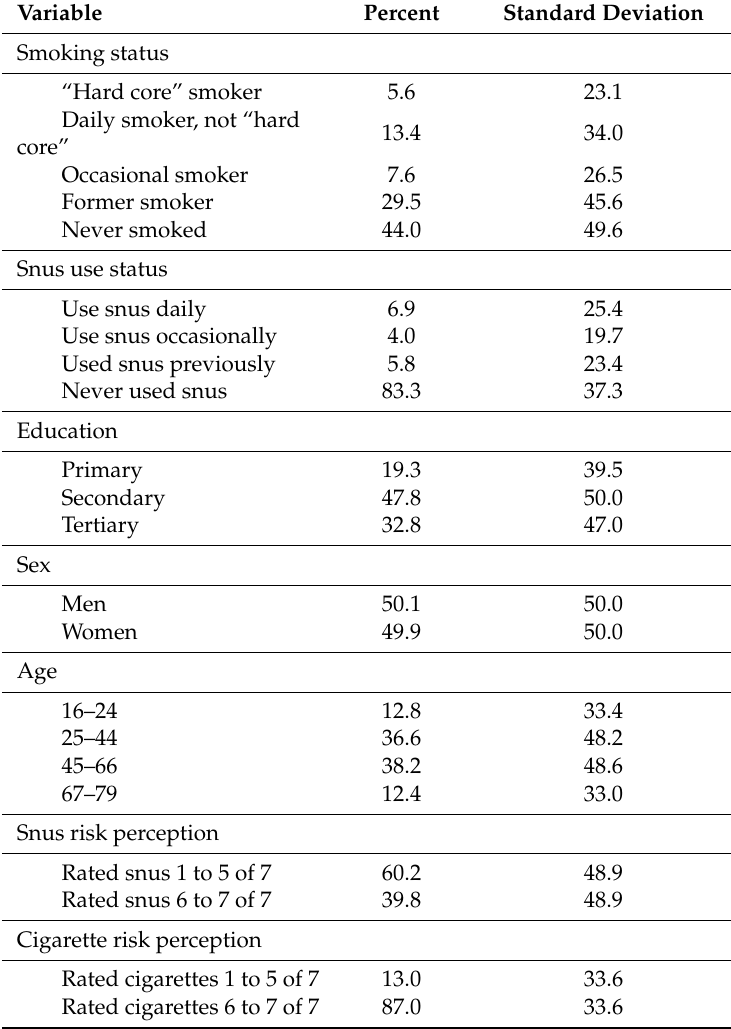
Table 1. Sample description, N =